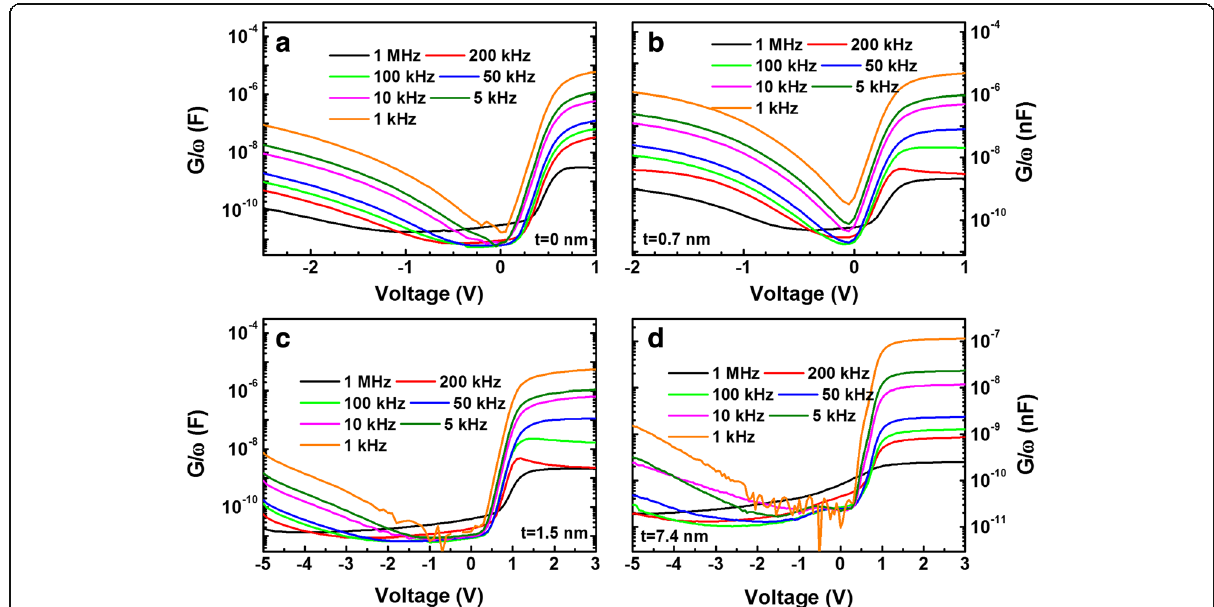
Fig. 4 Conductance – voltage ( G / ω – V ) data measured at various frequencies for the samples with a 0-, b 0.7-, c 1.5-, and d 7.4-nm-thick